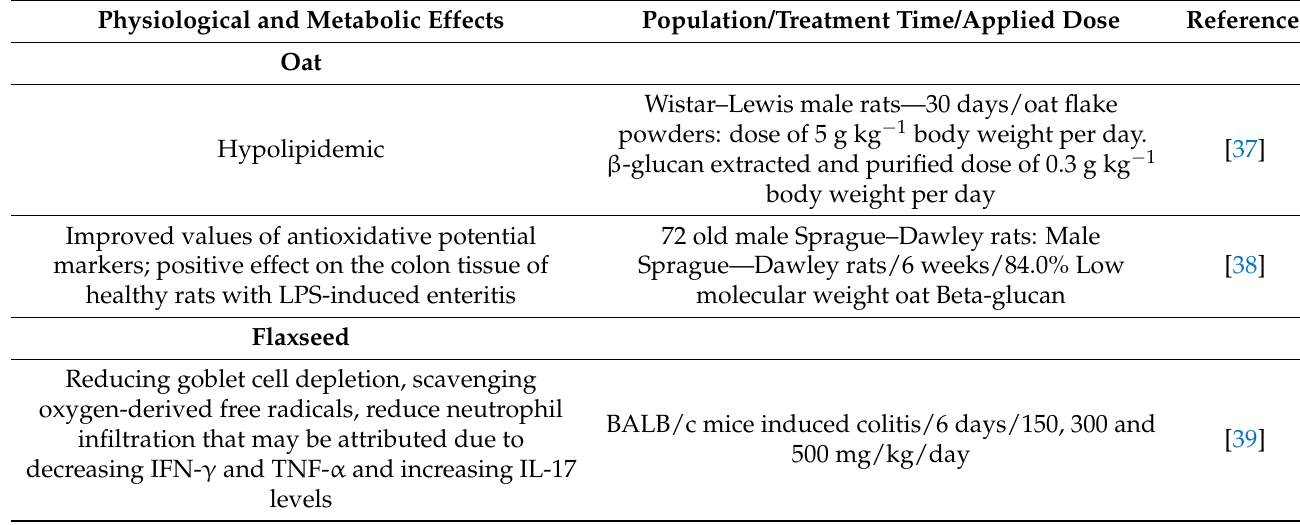
Table 2. BFC and M. oleifera nutraceutical bioactivity: in vitro and animal model bioassays. Physiological and Metabolic